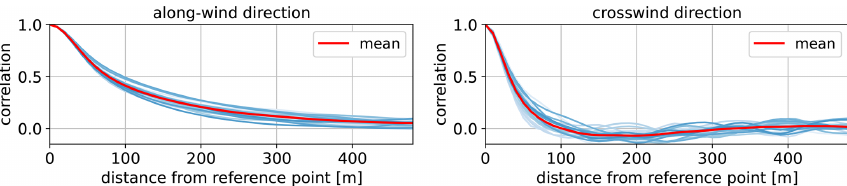
Figure 6. Correlation coefficients from Fig. 5 in the along-wind and crosswind directions for the streamwise component. Each blue curve represents a 15min interval, whereas the red curve is the mean over the time period of